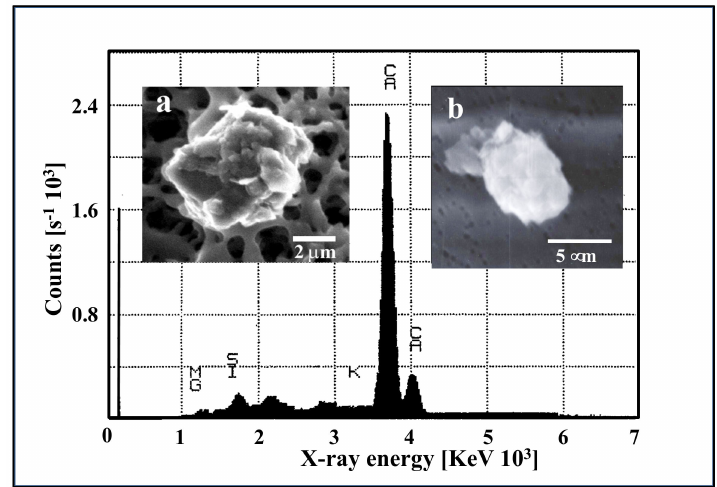
Figure 14. Electron probe microanalysis reveals that MGs contain substantially higher levels of Ca than Mg. Notice, that probably resulting from the Donnan partition, Ca reaches much higher concentrations inside self-assembled MG than in SW. Inset ( a ) is an environmental scanning electron micrograph image of a MG, the background depicts the surface of a filter—notice that this gel is intact and fully hydrated as environmental scanning electron microscopy (ESEM) does not require fixation or any other artifact-inducing chemical manipulation. Inset ( b ) is a gel labeled with CTC, a fluorescent probe that labels bound Ca and that, unlike other colorimetric probes, does not produce crosslinking of MBP or affect in any way the supramolecular structure of gels.